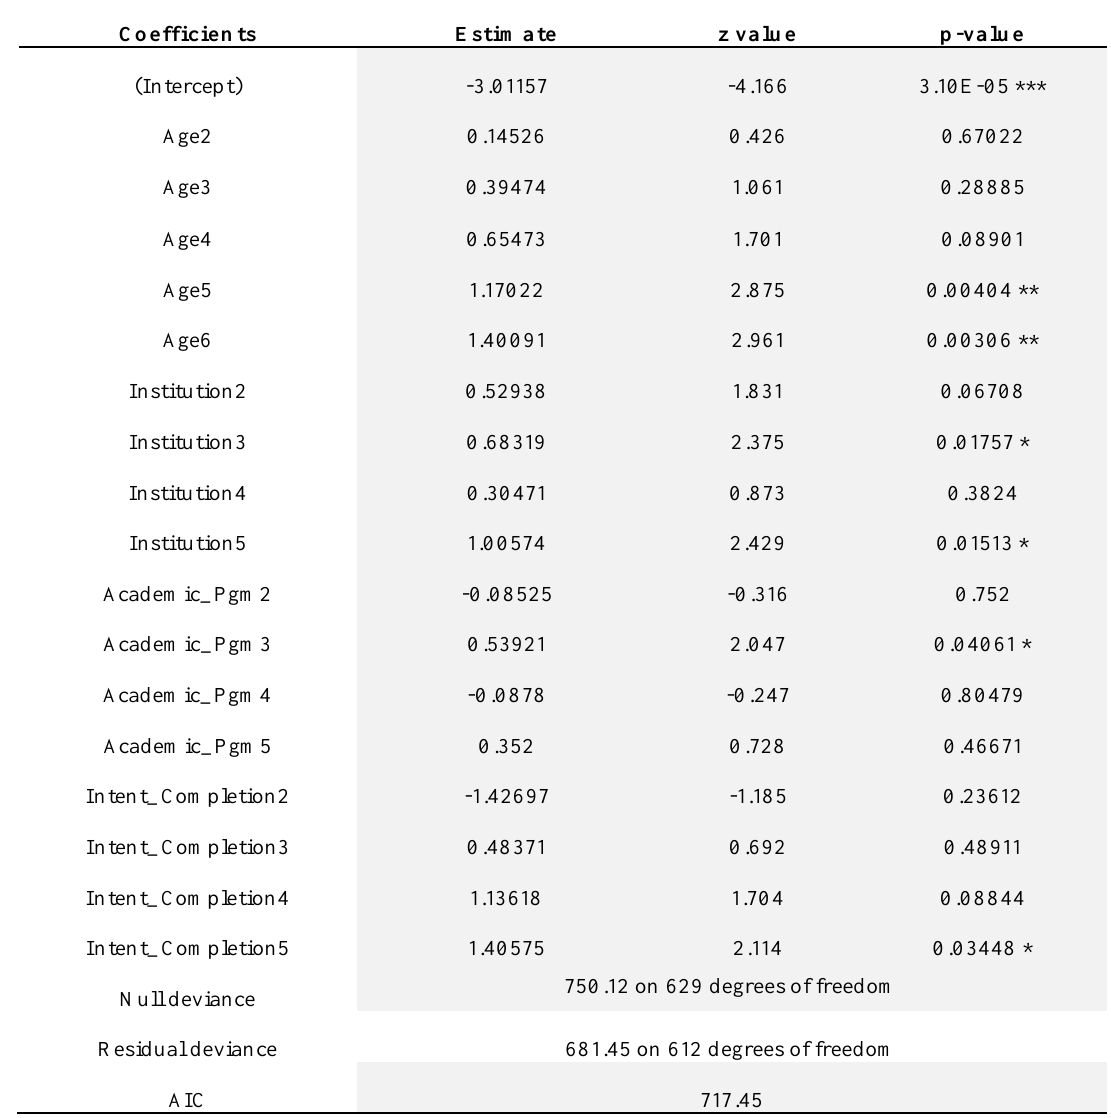
Model 3: Multiple Binomial Logistic Regression Presenting Age, Institution, Academic Program, and Intention to Complete the MOOC as Significant